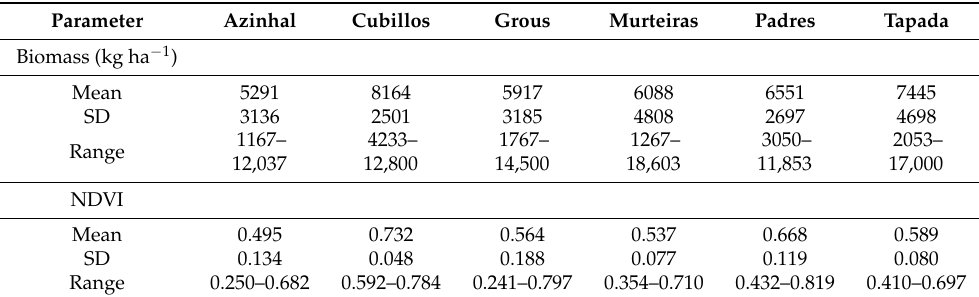
Table 5. Descriptive statistics (mean, standard deviation and range) of the pasture parameters in each of the six experimental fields used in this